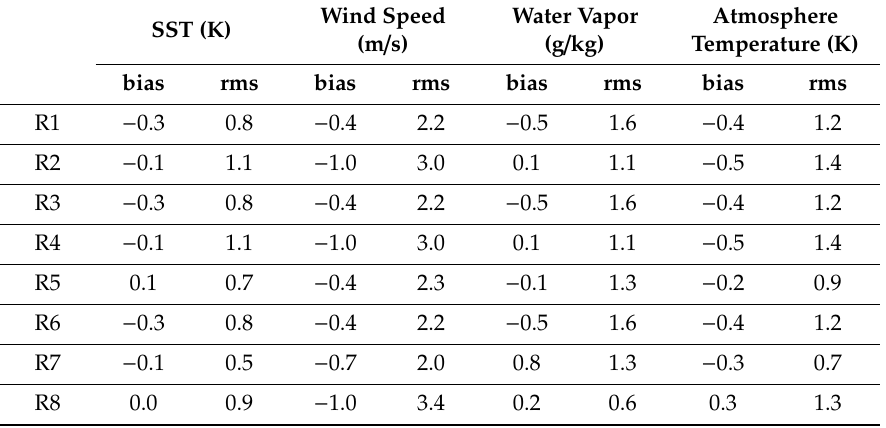
Figure 3. Eight oceanic regions within latitudes [45 ˚ S, 45 ˚ N] and longitudes [180 ˚ W, 180 ˚ E], where uncertainty from perturbed geophysical parameters is assessed. Table 3. Uncertainty in GDAS geophysical parameters for 8 oceanic regions *.